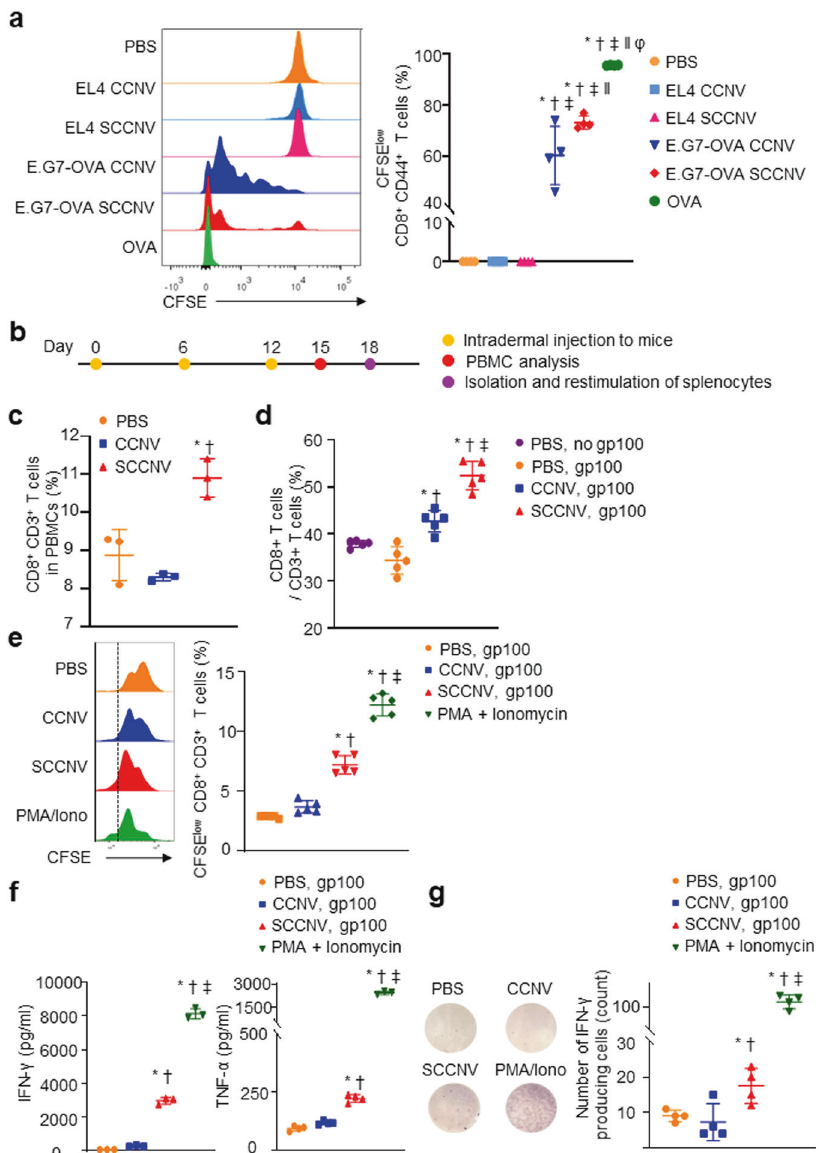
Fig. 5 Effective activation of tumor-speci fi c CD8 + T cells by SCCNVs in vitro and in vivo. a Flow cytometric analysis of the in vitro proliferation of naïve OT-I CD8 + T cells labeled with CFSE and subsequently cocultured for 72 h with splenic DCs that had been pulsed with PBS, ovalbumin peptide (OVA), CCNVs or SCCNVs. CCNVs and SCCNVs were produced from EL4-cancer cells or E.G7-OVA cancer cells. OVA was used as the positive control. b Timeline for the C57BL/6 mouse immunization study. c Flow cytometric analysis of CD8 + T cells in the PBMCs of mice immunized with intradermal injection of PBS, B16F10 cancer cell-derived CCNVs, or SCCNVs. d Ratio of CD8 + /CD3 + T cells in splenocytes harvested from mice that were immunized with PBS, B16F10 cancer cell-derived CCNVs, or SCCNVs and subsequently restimulated in vitro with the gp100 peptide (the tumor antigen of B16F10 cancer cells) for 72 h. e In vitro proliferation of CD8 + T cells during the restimulation of CFSE-labeled splenocytes harvested from mice that had been immunized with PBS, B16F10 cancer cell-derived CCNVs, or SCCNVs. PMA/ ionomycin (T-cell activation-inducing agents) served as the positive control. f Levels of IFN- γ and TNF- α , both of which are CD8 + T-cell activation markers, in the culture medium following the in vitro restimulation of splenocytes. The levels of IFN- γ and TNF- α were evaluated with ELISA. g ELISpot analysis of splenocytes harvested from mice immunized with various agents. The number of IFN- γ -producing cells per well was evaluated ( n = 4). Statistical signi fi cance was calculated by one-way ANOVA with Tukey ’ s multiple comparisons test. * P < 0.05 versus PBS in ( a – c ) and ( e – g ) or versus PBS, no pg100 in d ; † P < 0.05 versus EL4 cancer cell-derived CCNVs in a , versus CCNV in c , e , f and g , and versus PBS, gp100 in d ; ‡ P < 0.05 versus EL4 cancer cell-derived SCCNVs in ( a ), versus CCNVs in ( d ), and versus SCCNV in e , f and g ; ‖ P < 0.05 versus CCNVs in a ; φ P < 0.05 versus SCCNVs in a than in that of CCNV-immunized mice (Fig. 5g). Together, these Enzyme-linked immunosorbent assay (ELISA) analysis of super- results indicated that SCCNV immunization more effectively natants from cultures of gp100-pulsed splenocytes isolated from stimulated the activation of vaccine antigen (gp100)-speci fi c various groups of mice revealed higher IFN- γ and TNF- α levels in CD8 + T cells than did CCNV immunization. SCCNV-immunized mice (Fig. 5f), and an enzyme-linked immuno- spot (ELISpot) assay showed a higher number of IFN- γ -producing Next, we investigated whether SCCNVs can suppress tumor gp100-speci fi c T cells in the spleen of SCCNV-immunized mice growth in therapeutic and prophylactic melanoma mouse models.